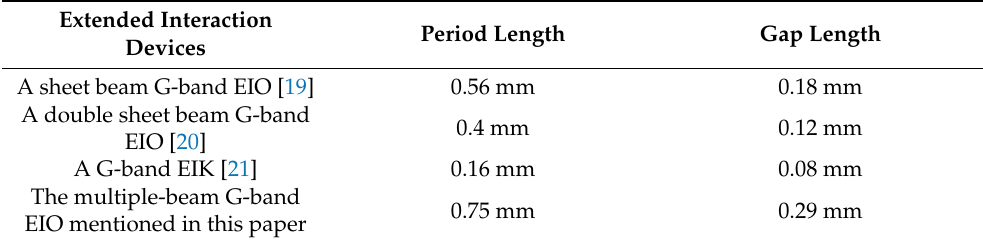
Table 1. Period lengths and gap lengths of various G-band extended interaction